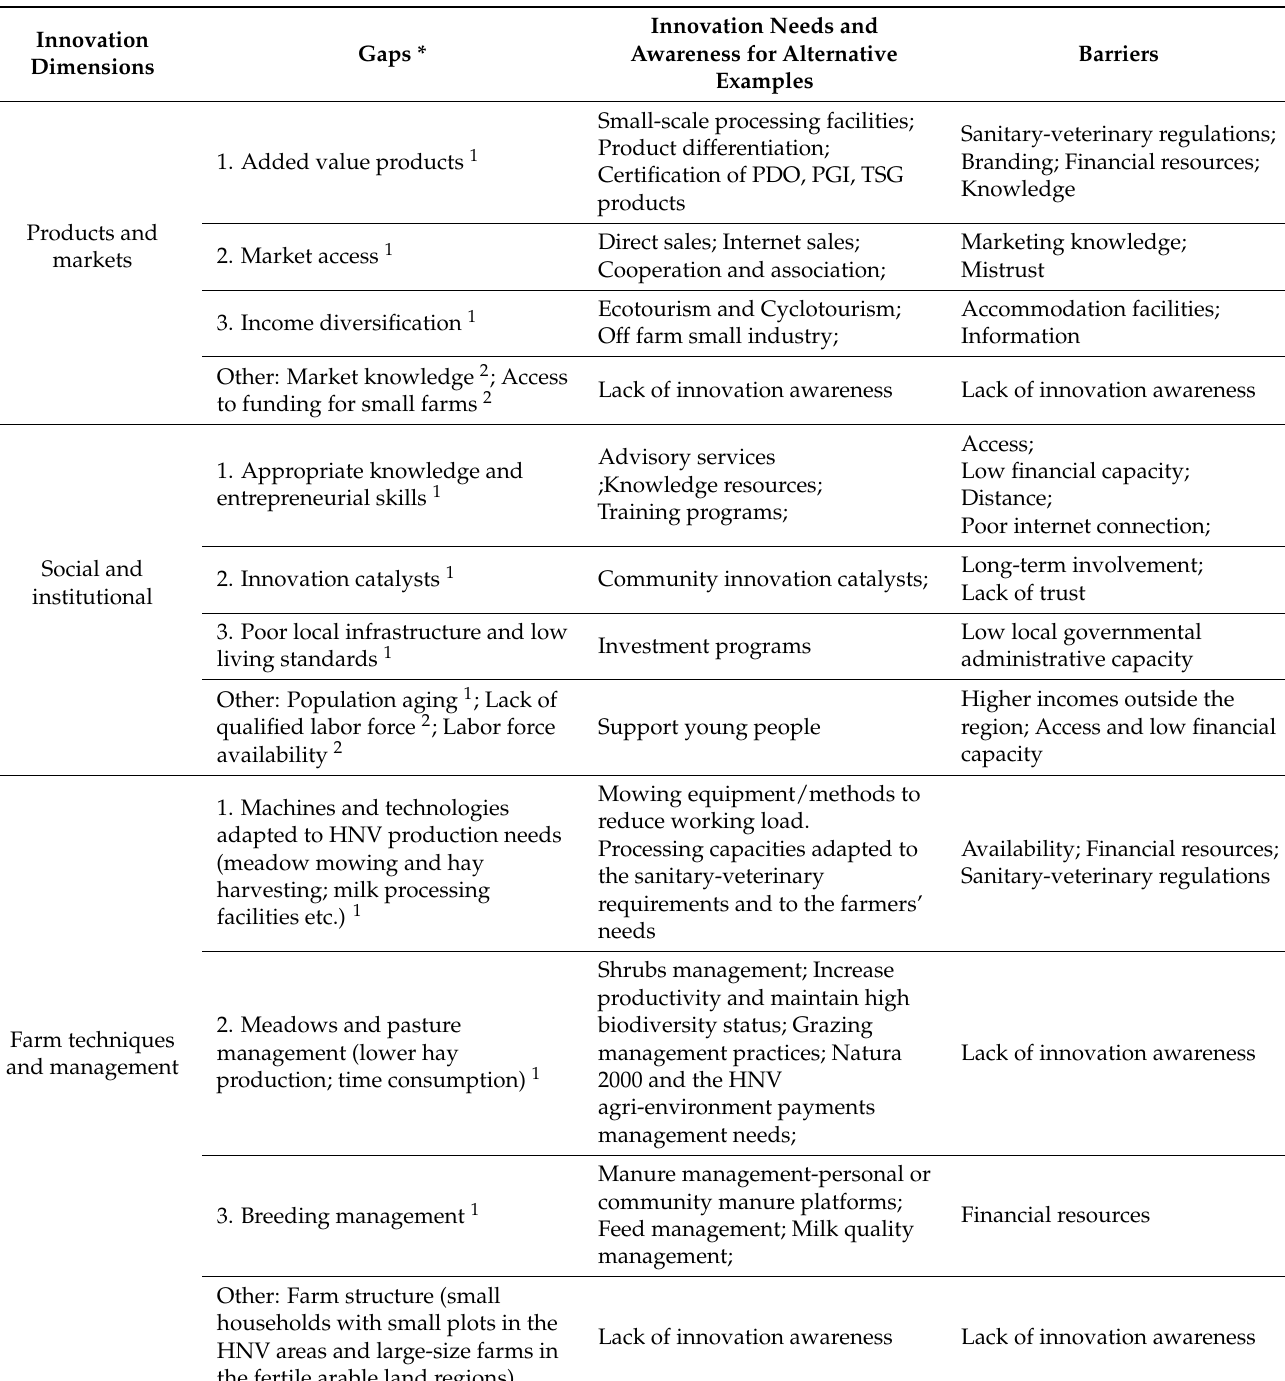
Table 4. Innovation gaps and needs within the studied